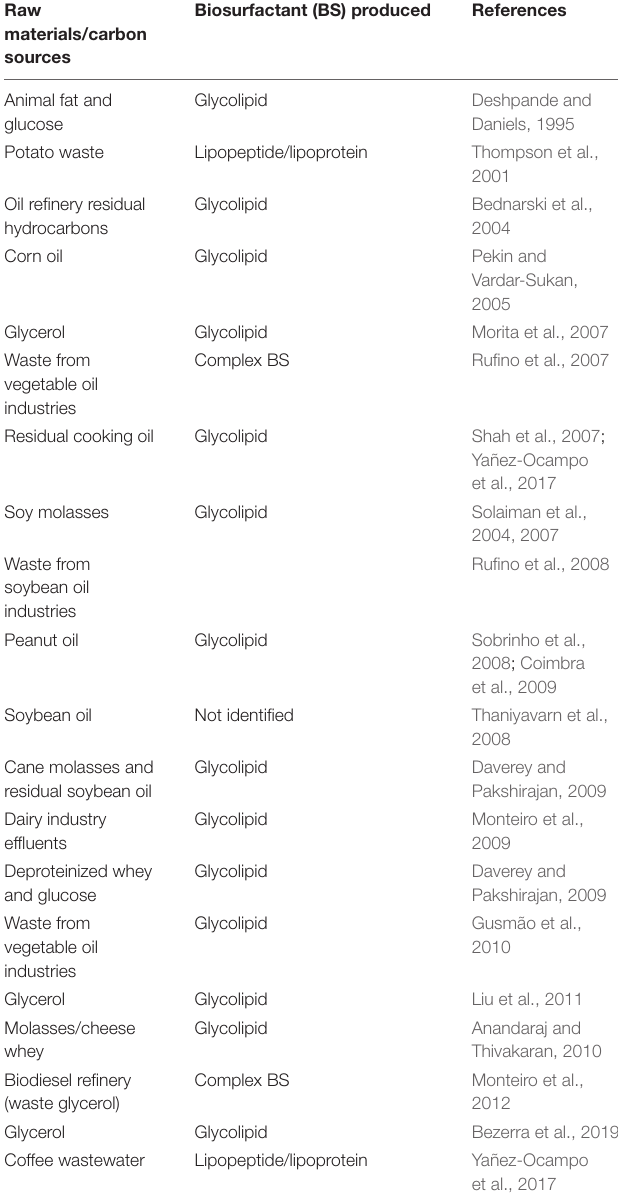
TABLE 5 | Raw materials used in BS